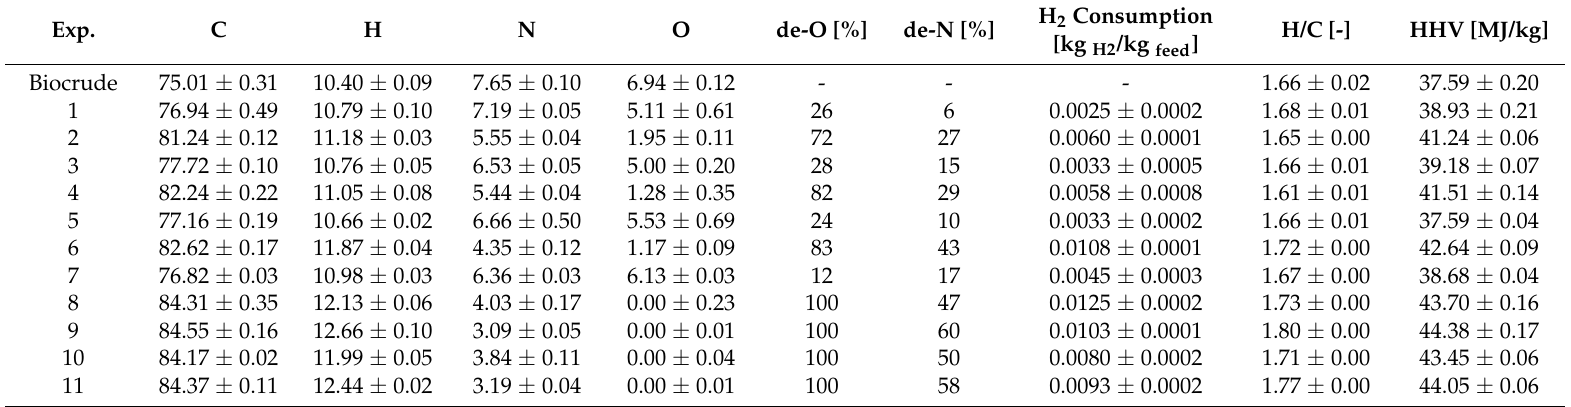
Table 4. Elemental composition (wt. %) along with the obtained responses (de-O and de-N) and their calculated effects until experiment 8. Oxygen is calculated by difference.